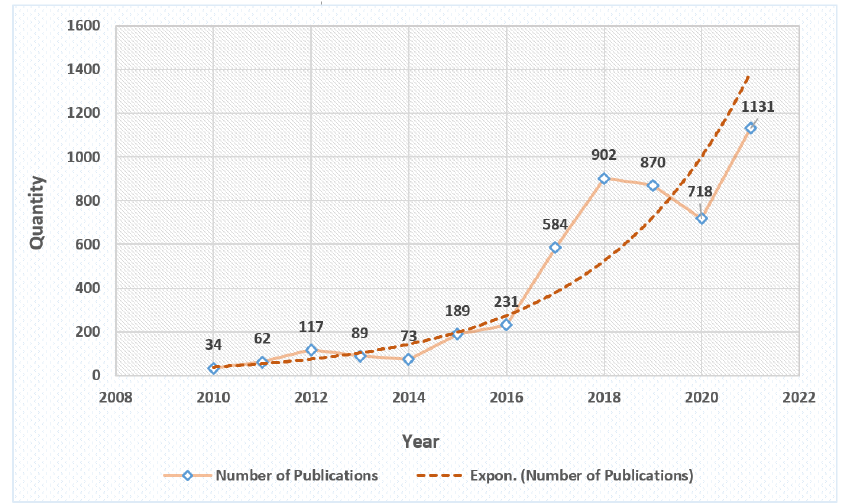
Figure 2. The number of related control logic injection attack publications per